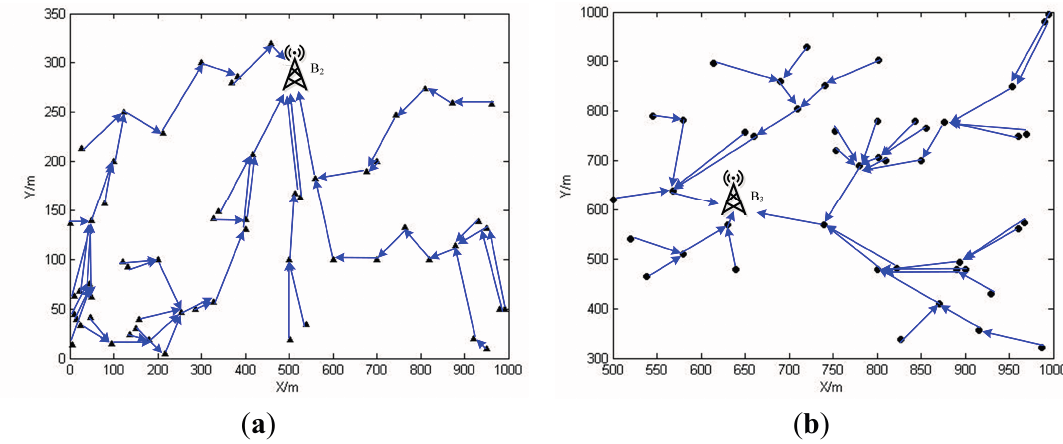
Figure 11. ( a ) The data routing schemes in phase 0 for phase 0 for SN . 3 Table 3. Results retrieved from the solution to OPT-4 for Node